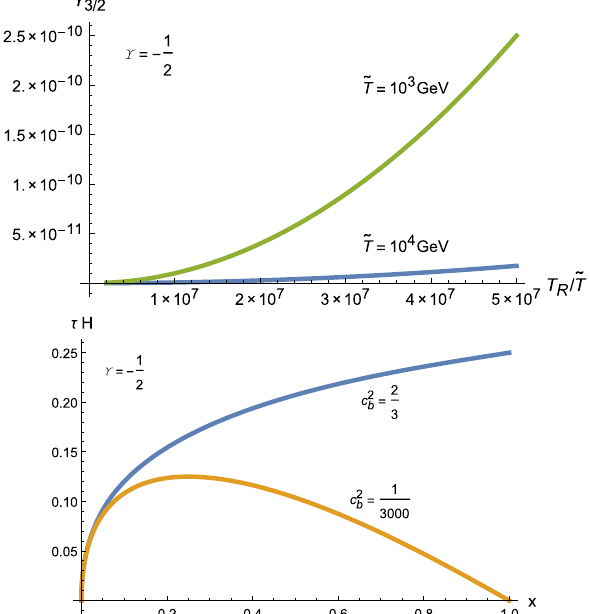
Fig. 3 Upper panel Y 3 / 2 vs. T R / ˜ T (see Eq. (3.14)), for different values of ˜ T such that T R (cid:11) ˜ T . Lower panel τ H vs. x = t / ˜ t (see Eq. (3.12)), with 0 (cid:2) x <